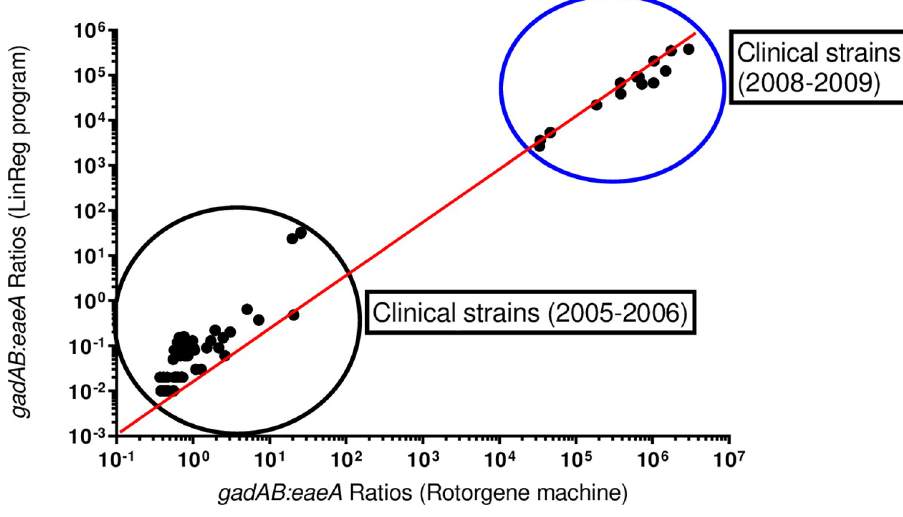
Fig 3. Graphs showing a comparison of the gene ratios as determined with Corbett Research Thermal cycler software versus the LinRegPCR program for combination gadAB vs eaeA for clinical strains (2005–2006) and clinical strains (2008–2009). The linear line indicated in each graph in red is a reference line where x = y.